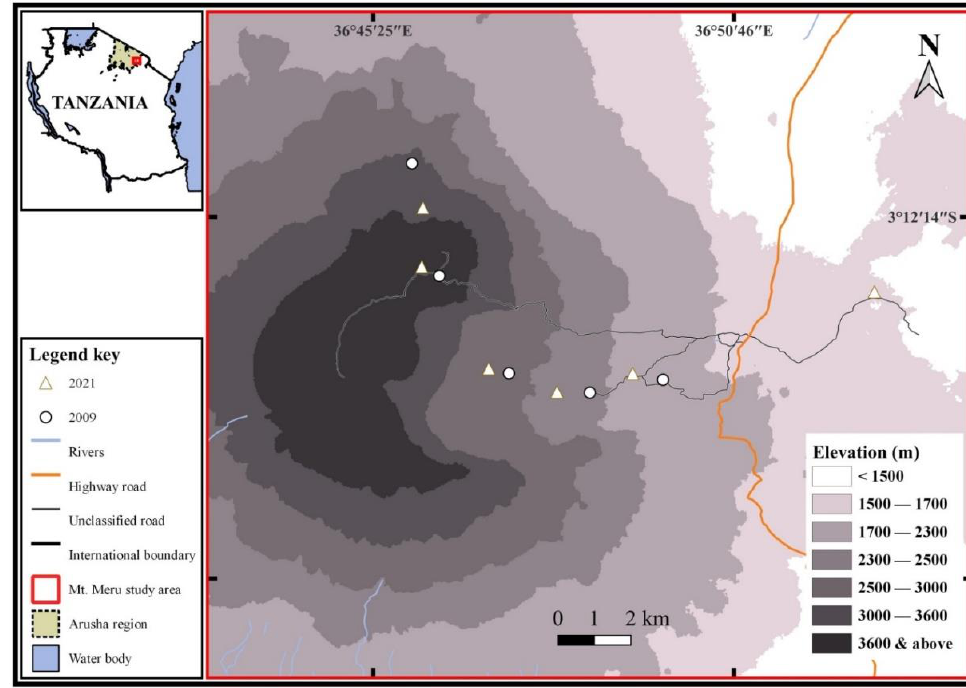
Figure 1. Map of Mount Meru, Tanzania, showing sampling points. Symbols indicate trapping elevations for 2009 (circle) and 2021 (triangle) studies. Elevation zones are represented with color in the legend.